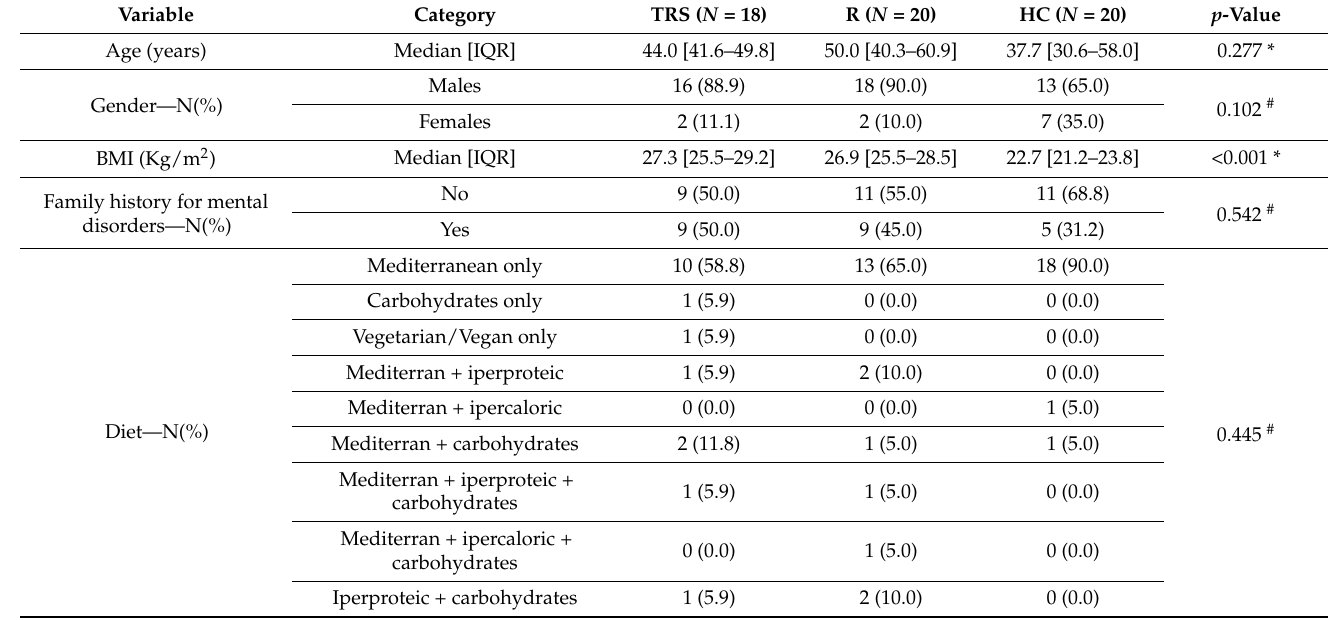
Table 1. Demographic and clinical characteristics of patients with SCZ classified according to their pattern of treatment response (TRS and R) and